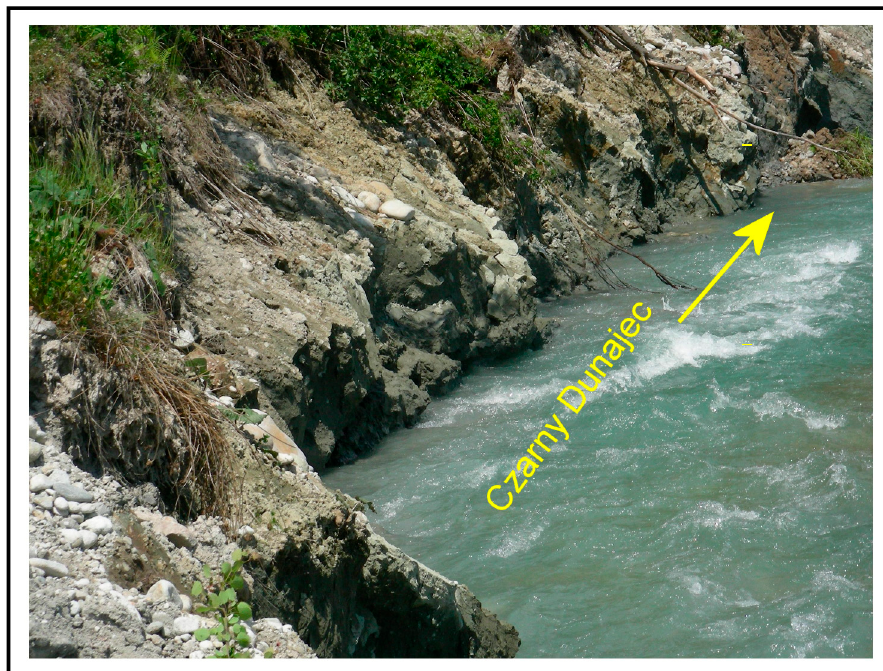
Figure 16. Erosion of the mudstones and claystones that underlie colluvium at site 1.